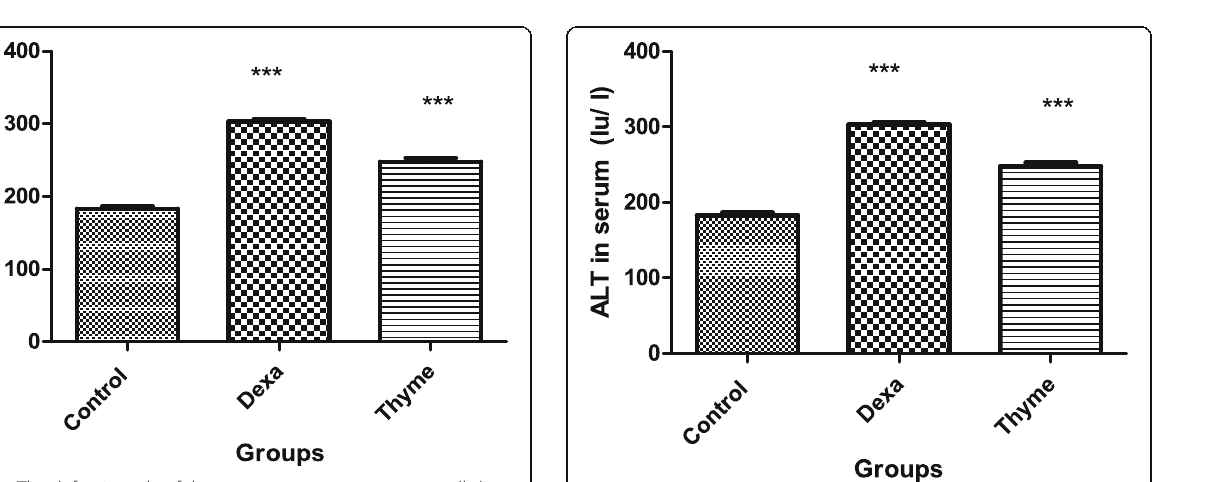
Fig. 1 The defensive role of thyme aqueous extract on serum alkaline phosphatase activity in normal and dexamethasone (DXM)-treated rats. Percentage changes (%) were calculated by comparing normal group with DXM-treated group and pre-treated DXM groups with